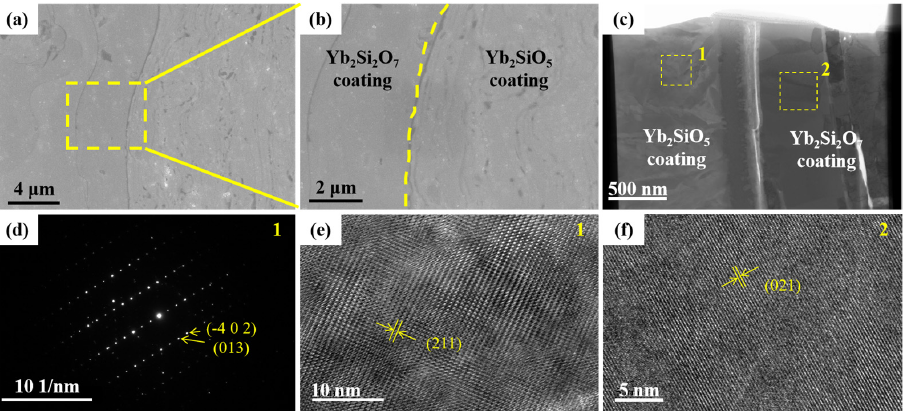
Figure 7. Cross-section micromorphology: ( a ) Yb 2 SiO 5 /Yb 2 SiO 7 interface; ( b ) enlargement of ( a ); TEM images: ( c ) bright field image of Yb 2 SiO 5 /Yb 2 SiO 7 interface; ( d ) the SAED pattern of the areas marked 1 in ( c ); ( e ) HRTEM image of the areas marked 1 in ( c ); ( f ) HRTEM image of the areas marked 2 in ( c ).